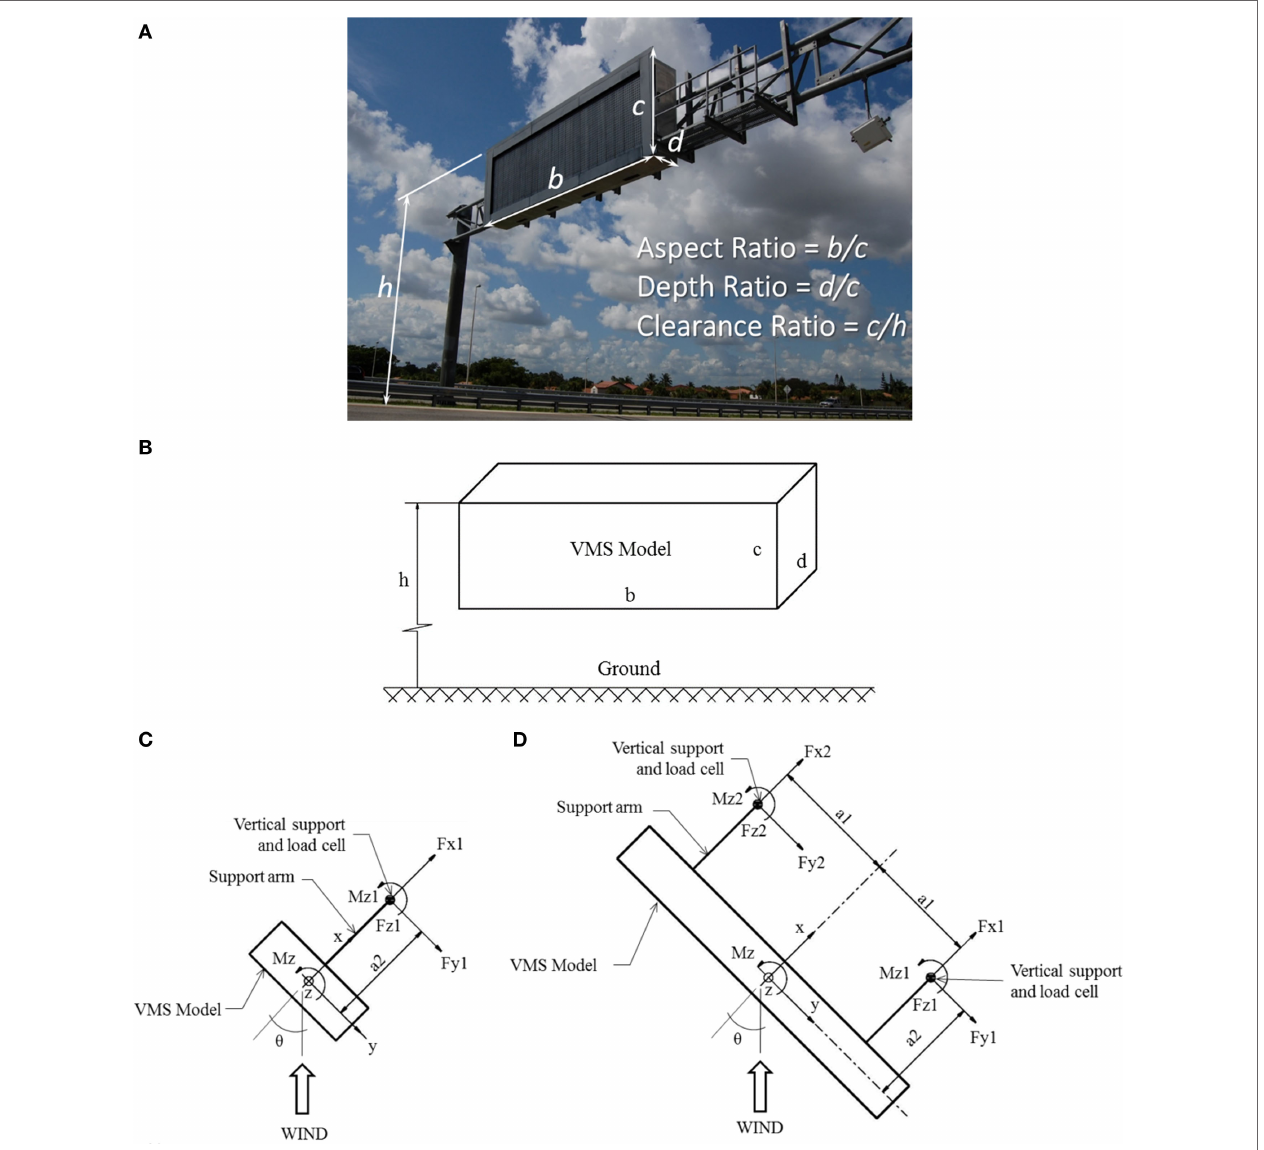
FIGURE 2 | Variable message sign: (A) VMS on Florida’s Turnpike highway (photo by D. Meyer); (B) schematic representation of the primary dimensions; (C) single support system; (D) double support system.